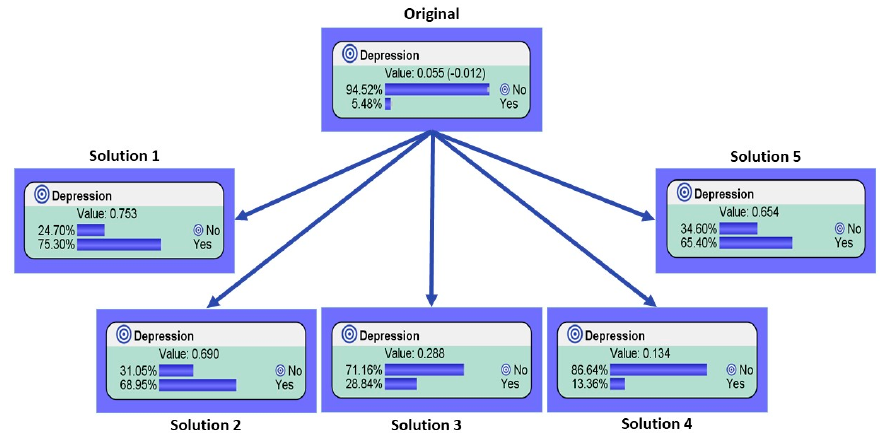
Figure 3. Based on the most probable causes found by the genetic optimization seen in Table 3, we explore the first three variables in Table 1, as well as gender and age, as these are non-subjective variables. The results show the di ff erence from the original status of the population sampled (5.48%) and if a person was to have the values seen in these five variables suggested by the genetic